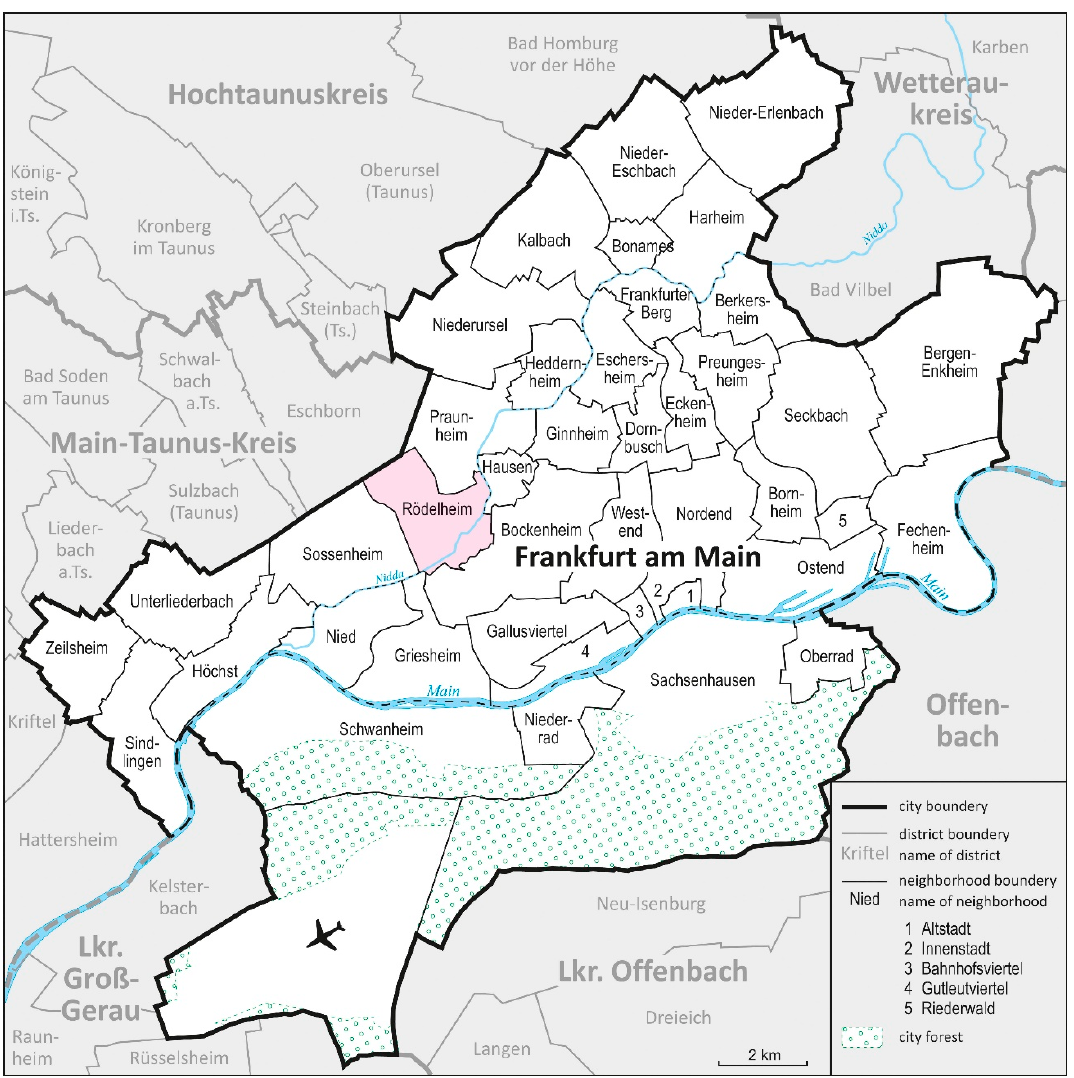
Figure 2. Map of the location of Rödelheim within Frankfurt (created by Department of Human Geography, Goethe-University Frankfurt, data provided by Stadt Frankfurt am Main 2019).